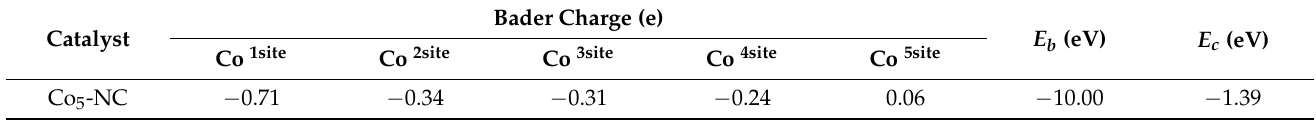
Table 2. The Bader charge of Co atoms in Co 5 -NC, binding energy ( E b ) between the Co 5 cluster and NC and the cohesive energy ( E c ) of Co atoms in the Co 5 cluster.